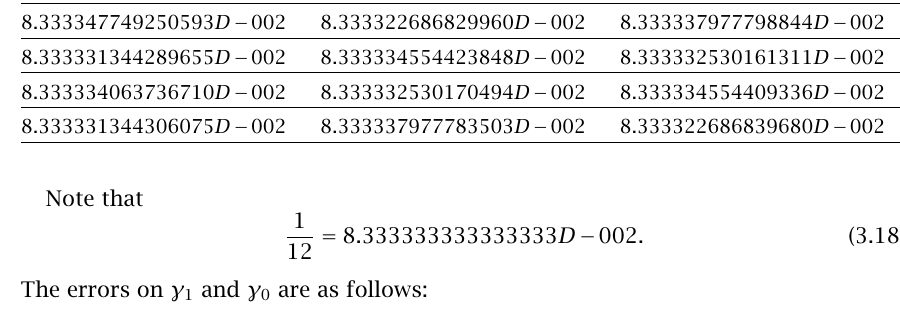
Table 3.15 . The errors with n = 12 , l = 0 . 25 on γ 1